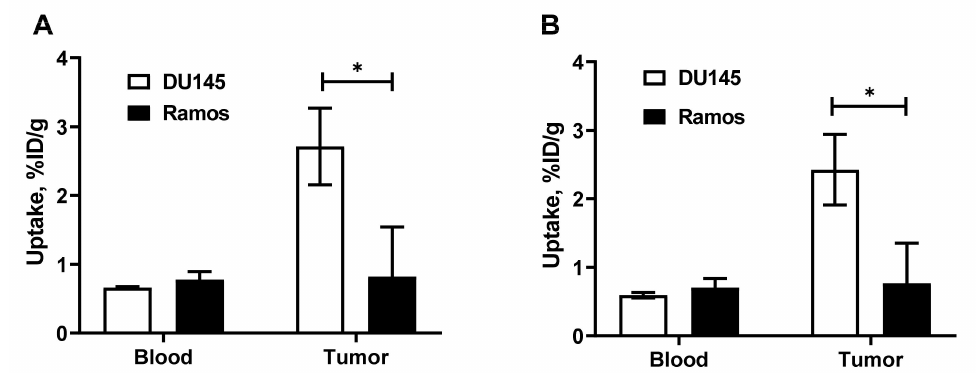
Figure 6. In vivo specificity: accumulation of [ 111 In]In-NODAGA-(HE) 3 -Z IGF-1R:4551 ( A ) and [ 68 Ga]Ga-NODAGA-(HE) 3 -Z IGF-1R:4551 ( B ) in IGF-1R-positive DU145 and IGF-1R-negative Ramos xenografts. Asterisk (*) marks a significant difference ( p < 0.05) between uptake in DU145 and Ramos